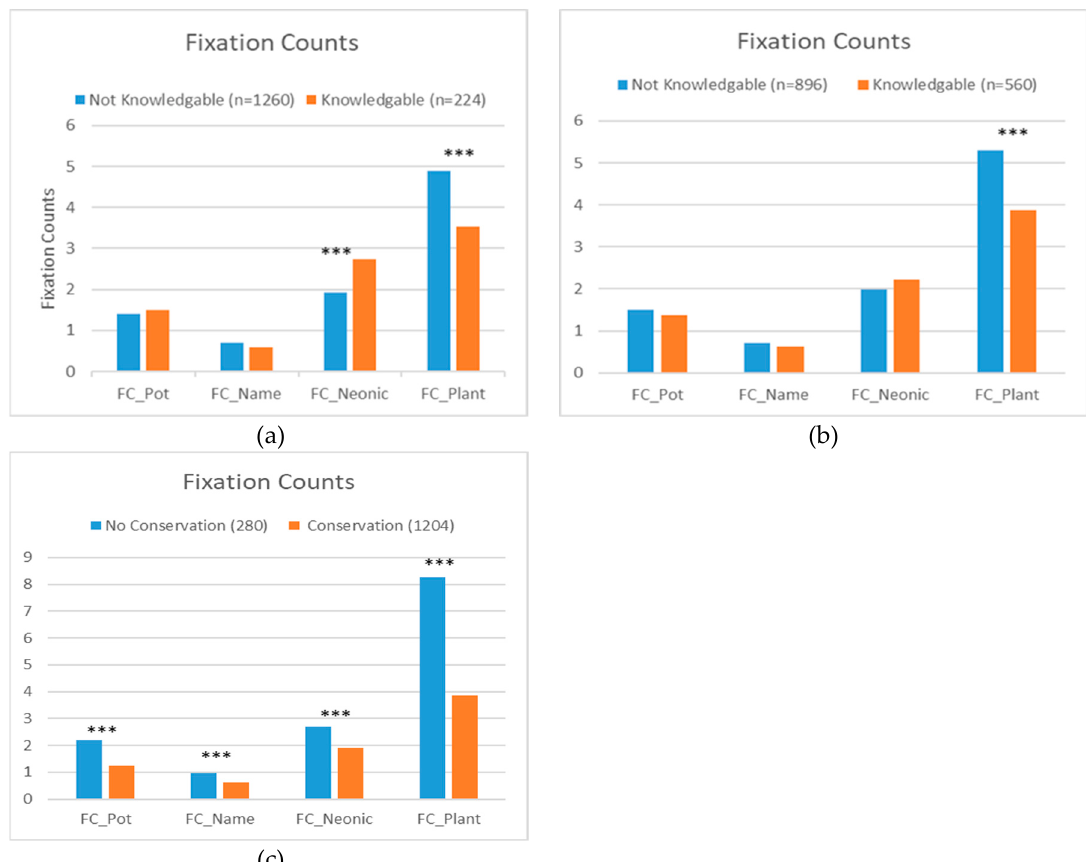
Figure 2. Fixation counts patterns by different groups. ( a ) by perceived knowledge about neonicotinoids; ( b ) by knowledge about pollinator attractive plants; ( c ) by conservation